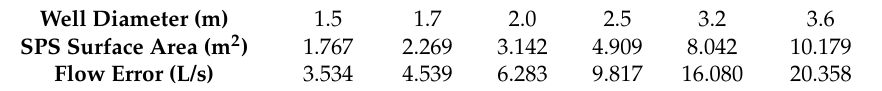
Table 1. The effect of radar accuracy on flow measurements.